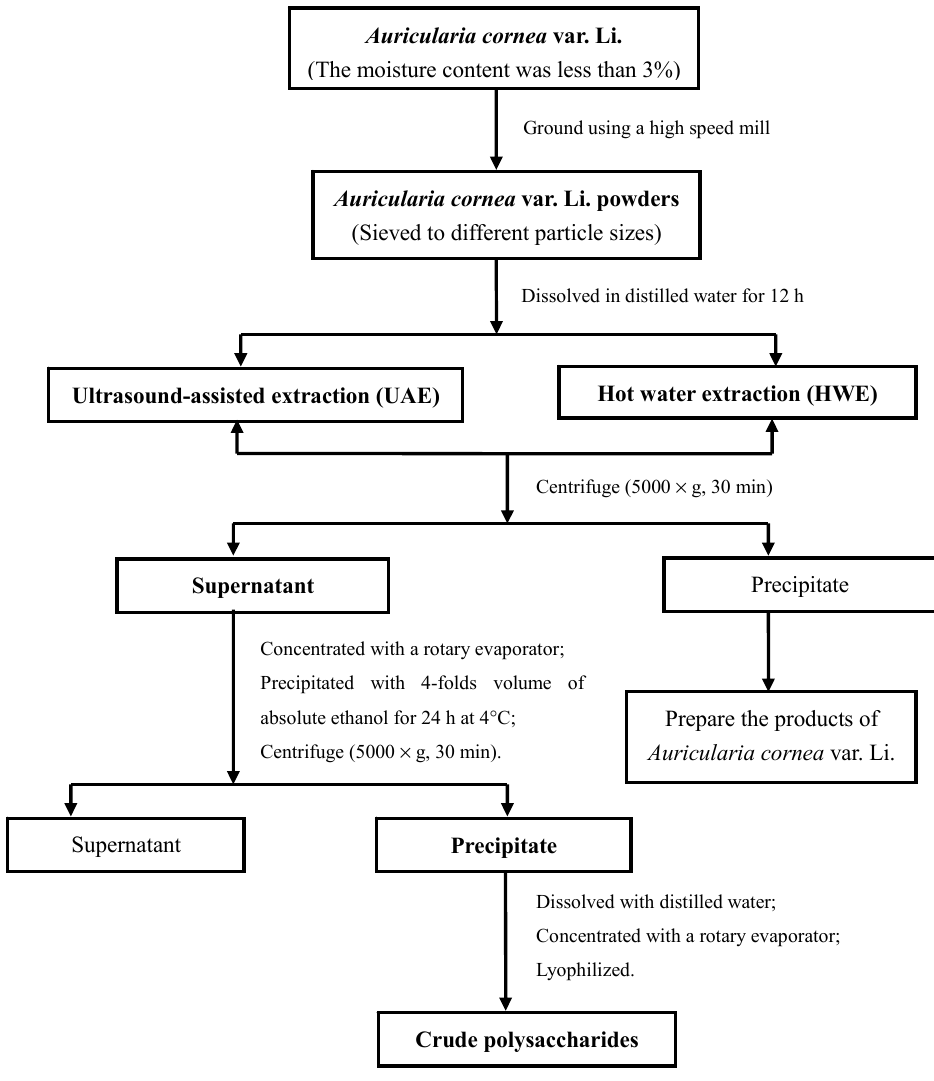
Figure 8. Flow chart and experimental design for the extraction process of polysaccharides from Auricularia cornea var. Li.